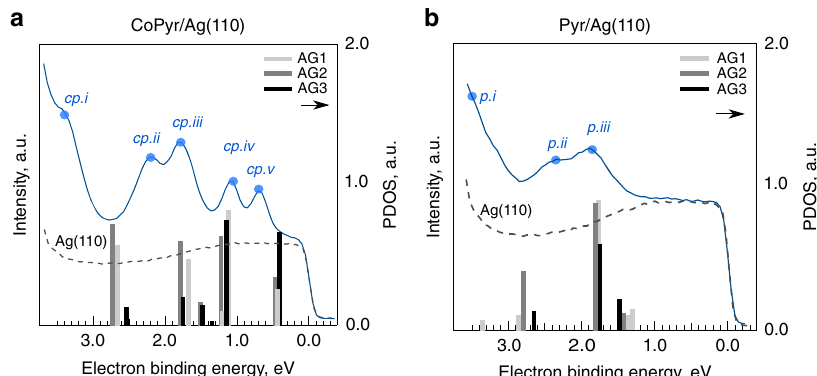
Fig. 3 Valence region photoelectron spectra. a Co-pyrphyrin (CoPyr) on Ag(110). b Pyrphyrin (Pyr) on Ag(110). CoPyr molecular states are marked as cp.i – cp.v , those of Pyr as p.i – p.iii . The projected density of states (PDOS) obtained from DFT for indicated adsorption geometries (AGs) is represented by grey- shaded bars. The Ag(110) substrate background is indicated by the grey dashed line